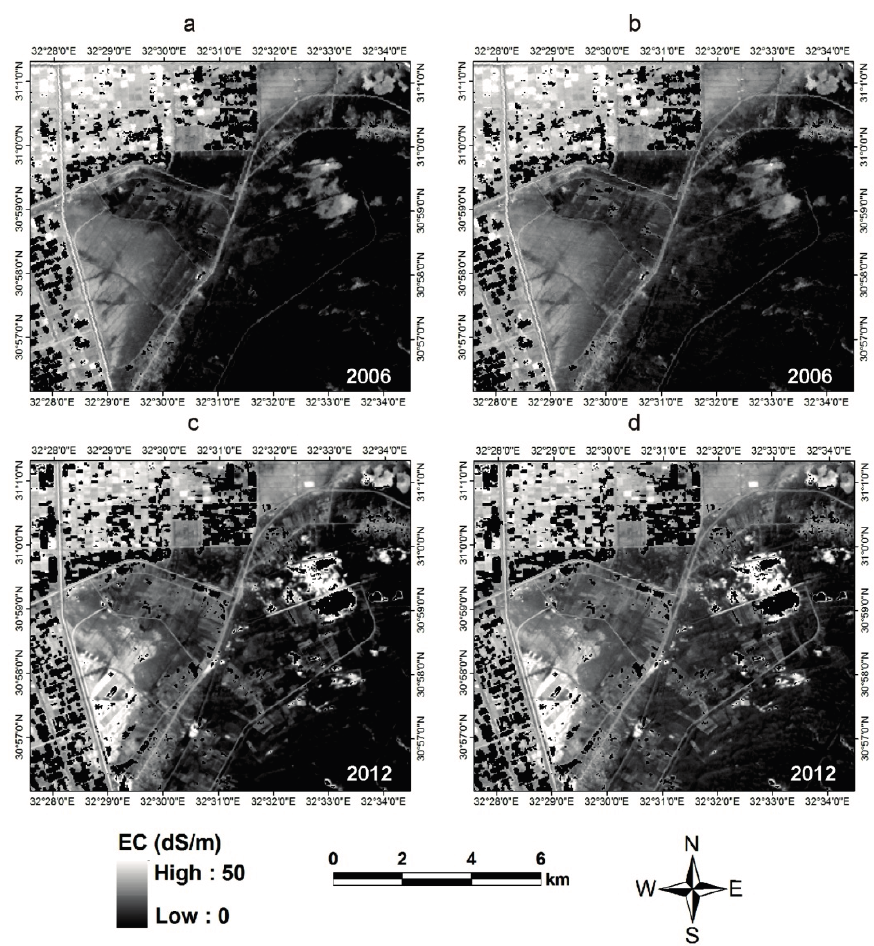
Figure 6. Soil salinity maps (EC e ). ( a ) PLSR results for 2006; ( b ) MARS results for 2006; ( c ) PLSR results for 2012; and ( d ) MARS results for